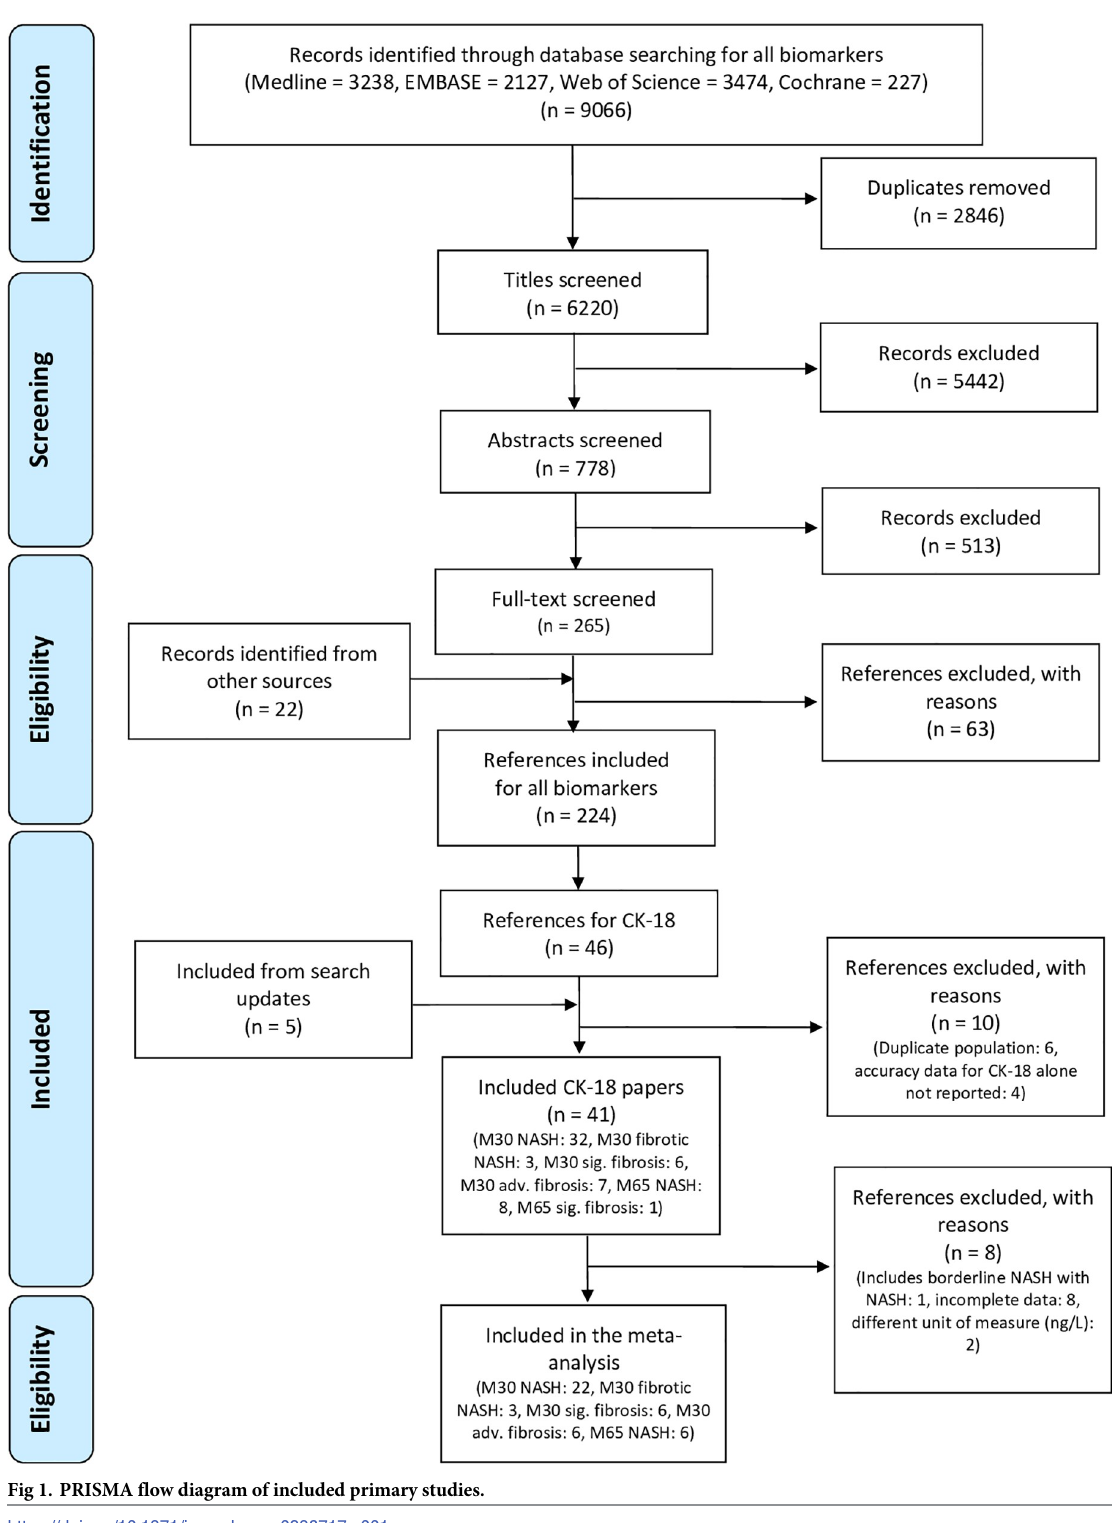
Fig 1. PRISMA flow diagram of included primary studies.